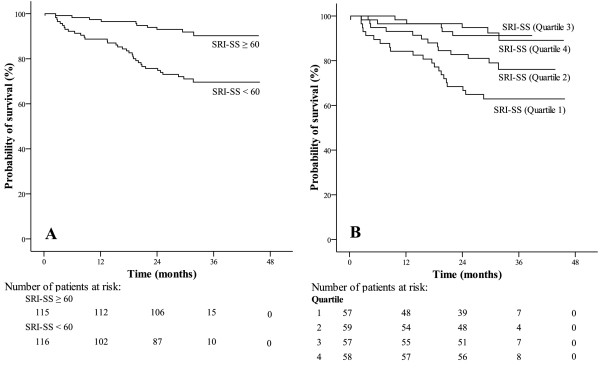
Prognostic value of HRQL in the total population of patients (n = 231) using the median (Panel A; SRI-SS 60.0) as cut-off value (HR 0.262; 95%-CI 0.129–0.530; p < 0.001) or the quartiles (Panel B; 0–49.7, quartile 1; 49.7–60.0, quartile 2; 60.0–74.9, quartile 3; > 74.9, quartile 4; log rank; HR 0.533; 95%-CI 0.394–0.722; p < 0.001).